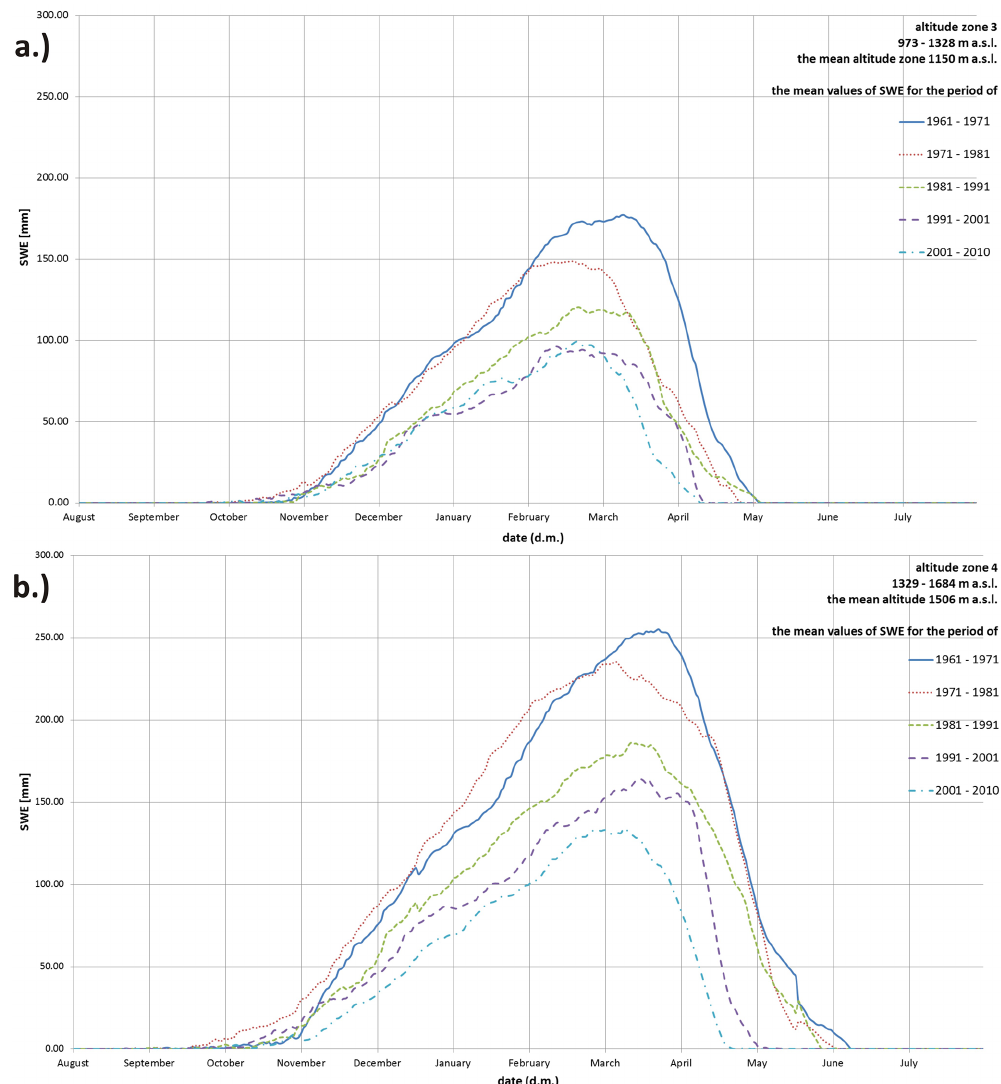
Figure 4. Simulated mean daily SWE for each decade in (a) the third and (b) the fourth altitude zones of the Upper